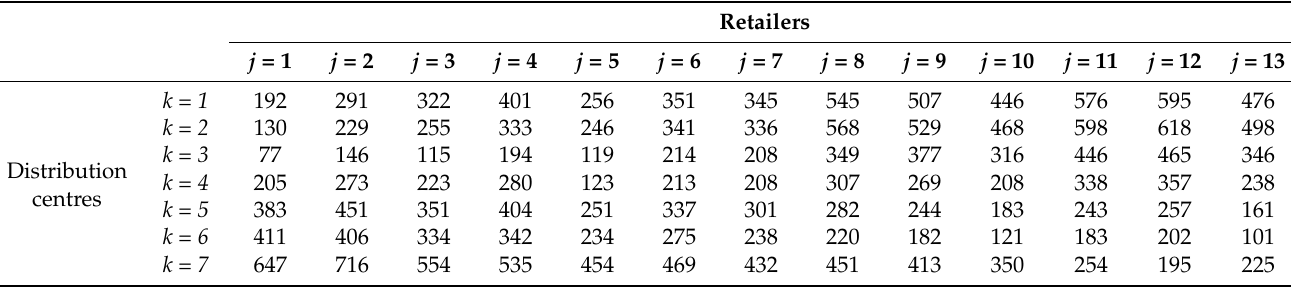
Table A2. Used distances between distribution centres and retailers